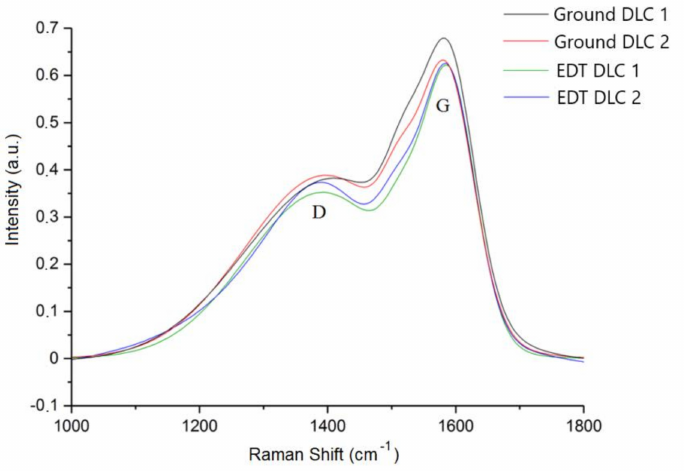
Figure 9. Raman spectra for ground DLC and EDT DLC specimens, two measurements per